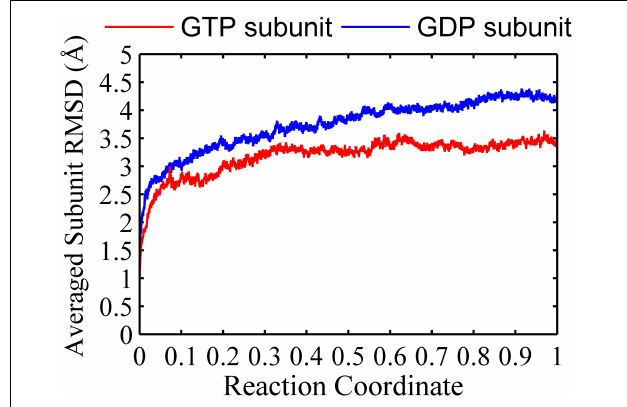
FIGURE 6 | Root mean square deviations of the C α atoms of subunits from the initial conformation as a function of time. Red line: GTP-bound subunit. Blue line: GDP-bound subunit. Reaction coordinate: 0 represent 0 ns and 1 represented 150 ns and 450 ns for GTP and GDP state, respectively. The RMSDs are from a starting zero for initial subunit conformation. In all the cases, the RMSDs are calculated by averaging all of the three subunits of trimers in GTP-bound (two runs) or GDP-bound (three runs) trajectories.